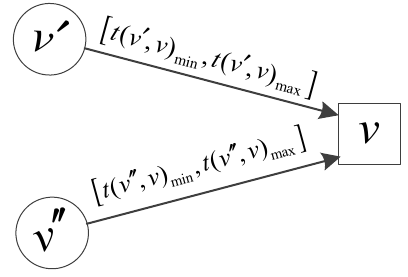
Figure 2. Diagram of AND causality relationship.